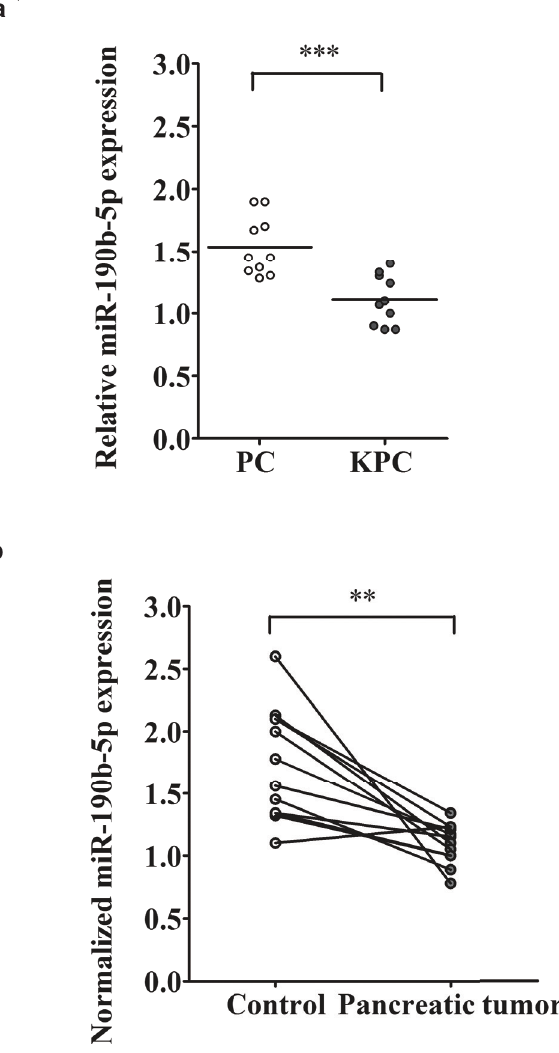
Fig. 7. MiR-190b-5p is downregulated in pancreatic cancer. (a) The comparison of miR-190b-5p expressional levels in pancreatic tissues between PC and KPC mice. The pancre- atic tissues were harvested, and the miRNA expression was analyzed by real-time PCR. Ten subjects were studied from each group. (b) The expressional levels of miR-190b-5p in 10 pancreatic cancer tissues and the matched non-tumor tissues were quantified by real-time PCR (** P < 0.01, significantly different from control group in a pair-wise student t